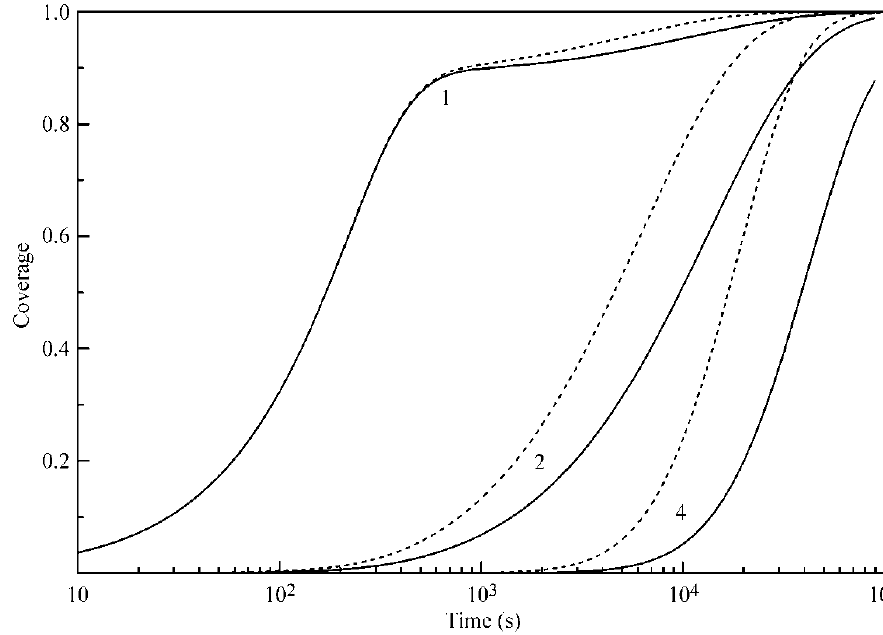
Figure 8. Dynamics of the coverage of Layers 1, 2 and 4 at 30 °C for two different b 2 values. For detailed discussion, see text.